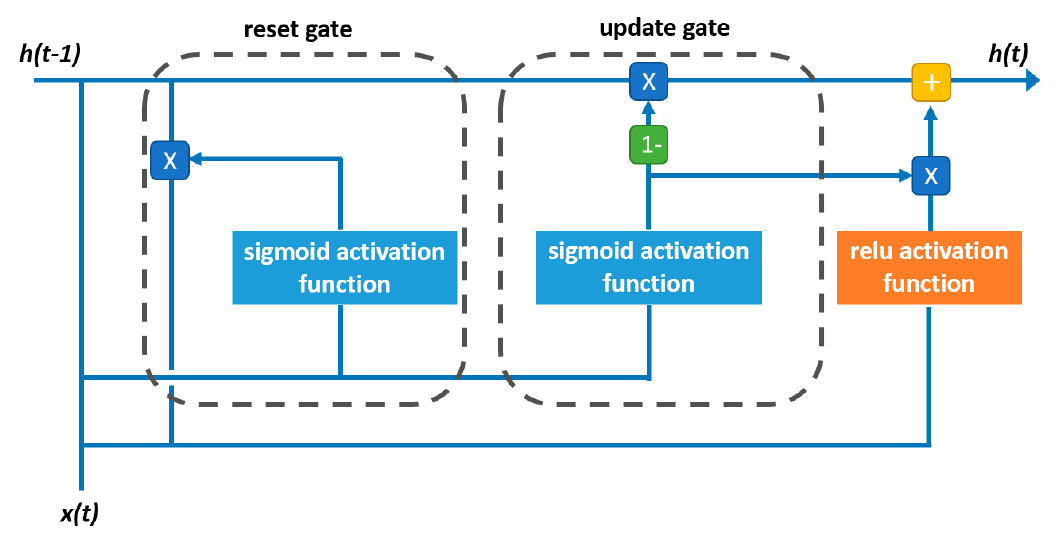
Figure 1. RNN structure using one GRU hidden layer.